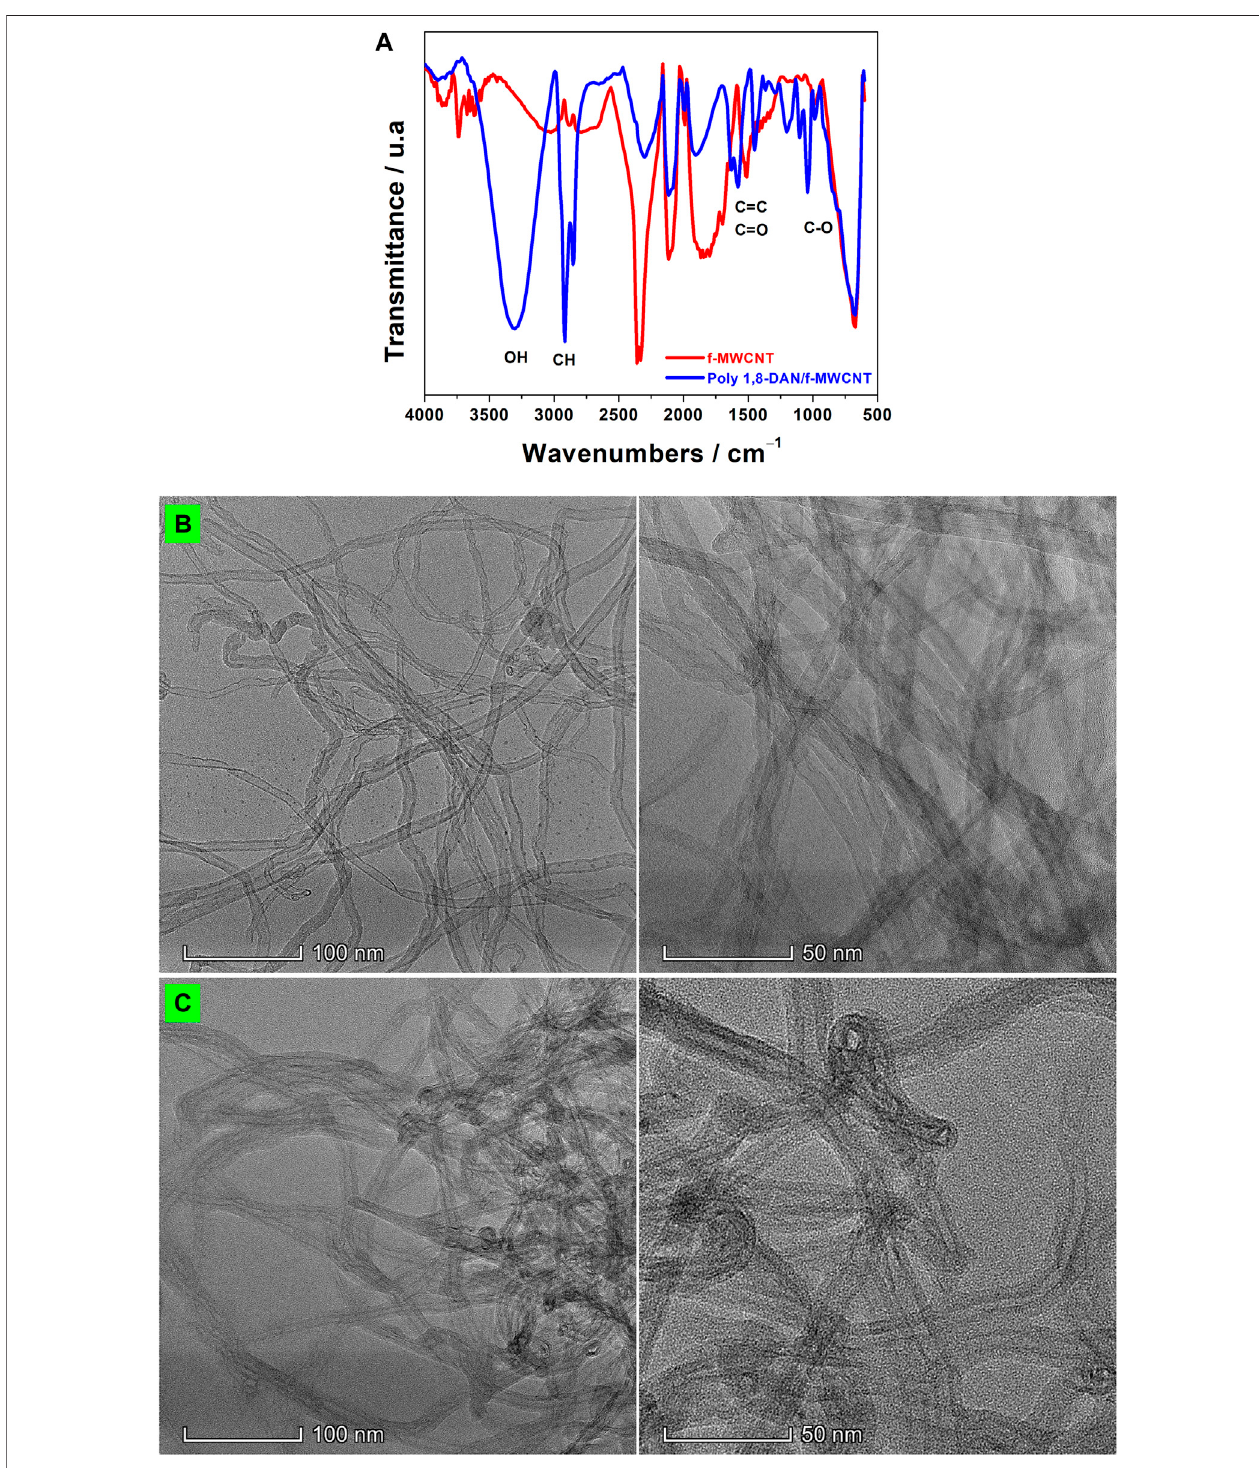
FIGURE 3 | (A) FTIR spectra of f-MWCNT (red line), and poly 1,8-DAN/f-MWCNT (blue line). TEM images of (B) f-MWCNT, and (C) poly 1,8-DAN/f-MWCNT.